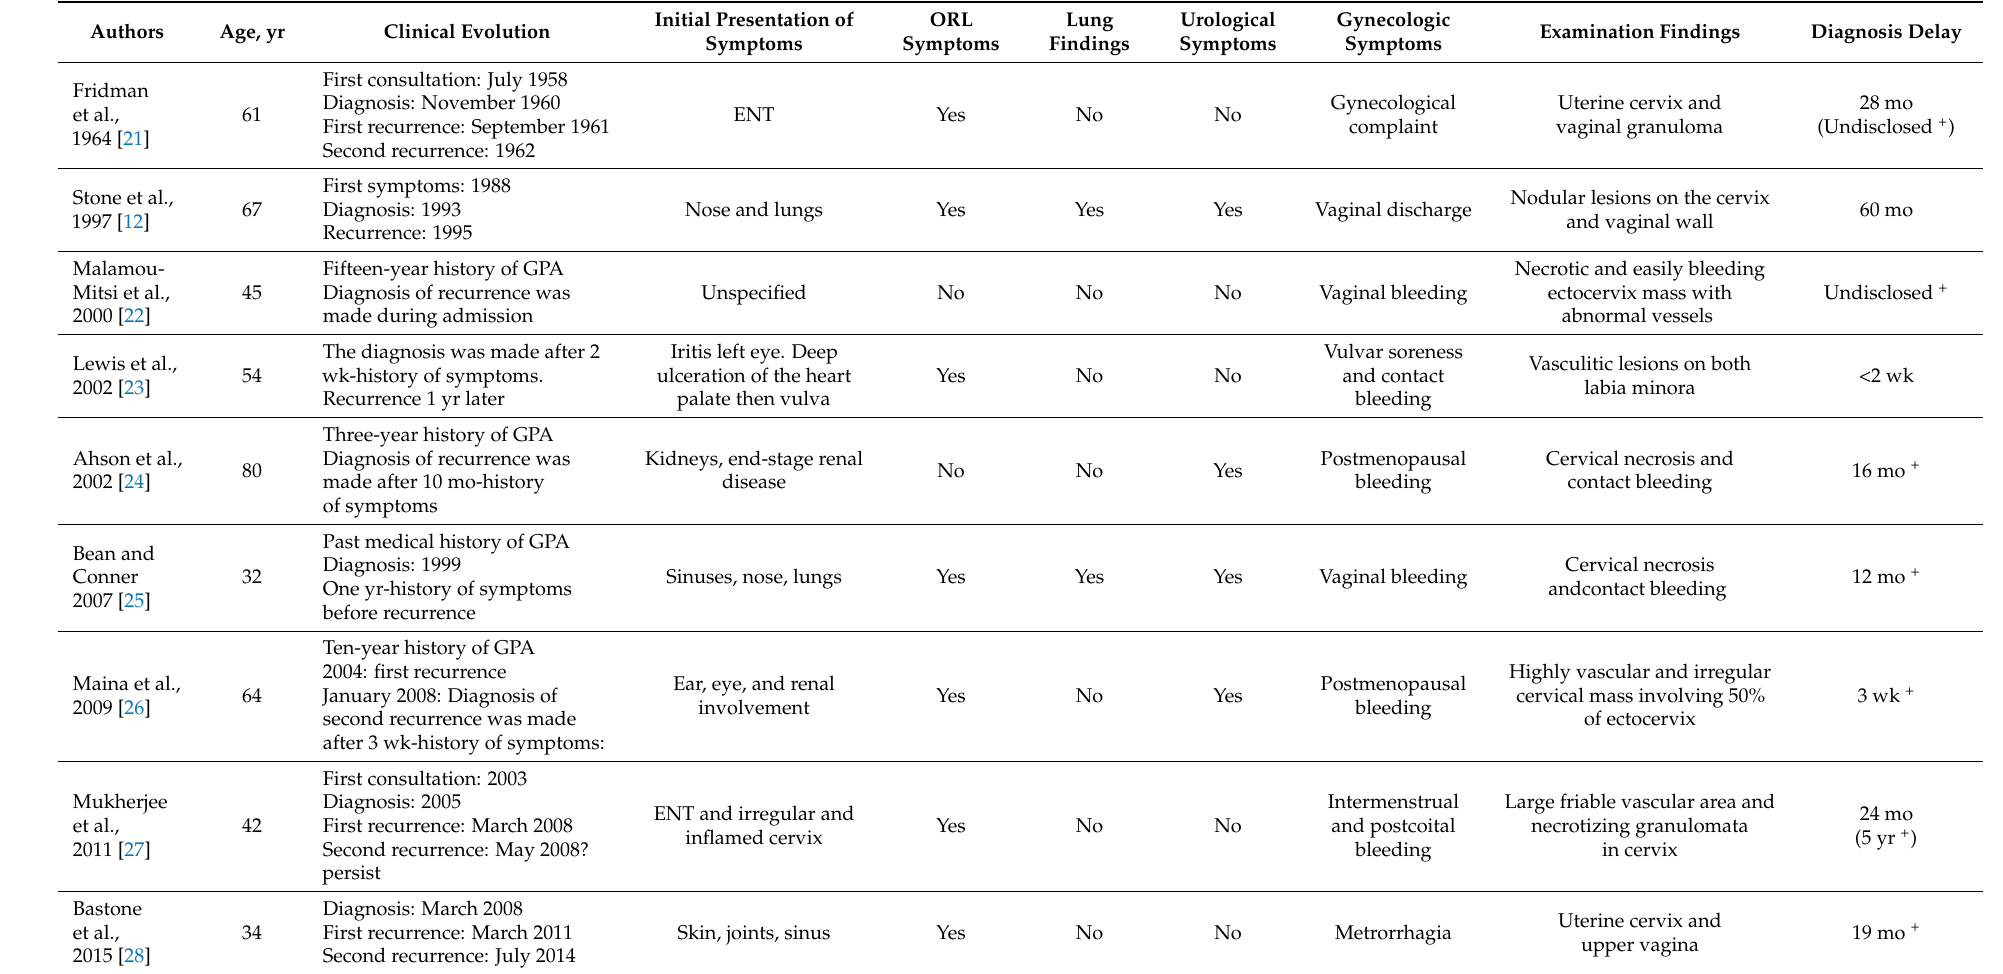
Table 2. Literature review of patients with previous history of GPA and gynecological